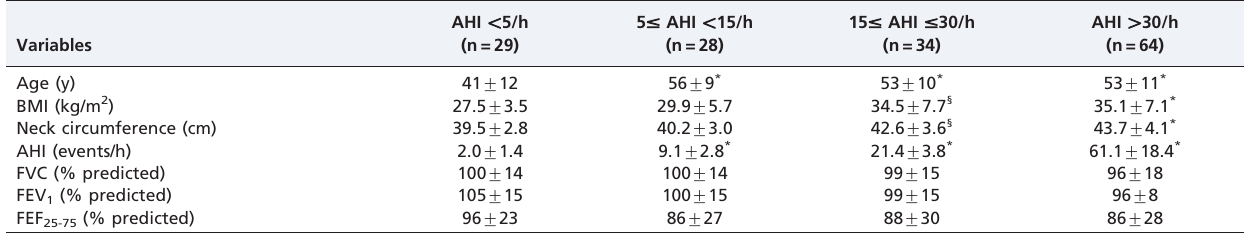
AHI and V 0.2 (%), V 0.5 (%), and V 1.0 (%) are shown in Figure 2. Figure 3 shows the mean expiratory volumes at V 0.2 (%), V 0.5 (%), and V 1.0 (%) for the healthy subjects and the subjects in the three different OSA severity groups. Exhaled V 0.2 (%) and V 0.5 (%) volumes were significantly lower ( p , 0.01) in all OSA severity groups, than in healthy subjects. The exhaled V 1.0 (%) volume, however, was only significant for the healthy subjects compared with the moderate and severe OSA subjects. The expiratory volumes were associated with disease severity (i.e., the expiratory volume decreased as disease severity increased), and the highest volumes were found in the healthy subjects. A ROC curve analysis was applied to evaluate the predictive effectiveness of V 0.2 (%), V 0.5 (%), and V 1.0 (%) for OSA subjects with AHI $ 5, AHI $ 15 and AHI . 30. The predictive parameters for V 0.2 (%), V 0.5 (%), and V 1.0 (%) are reported in Table 2. Interestingly, V 1.0 (%) was the least